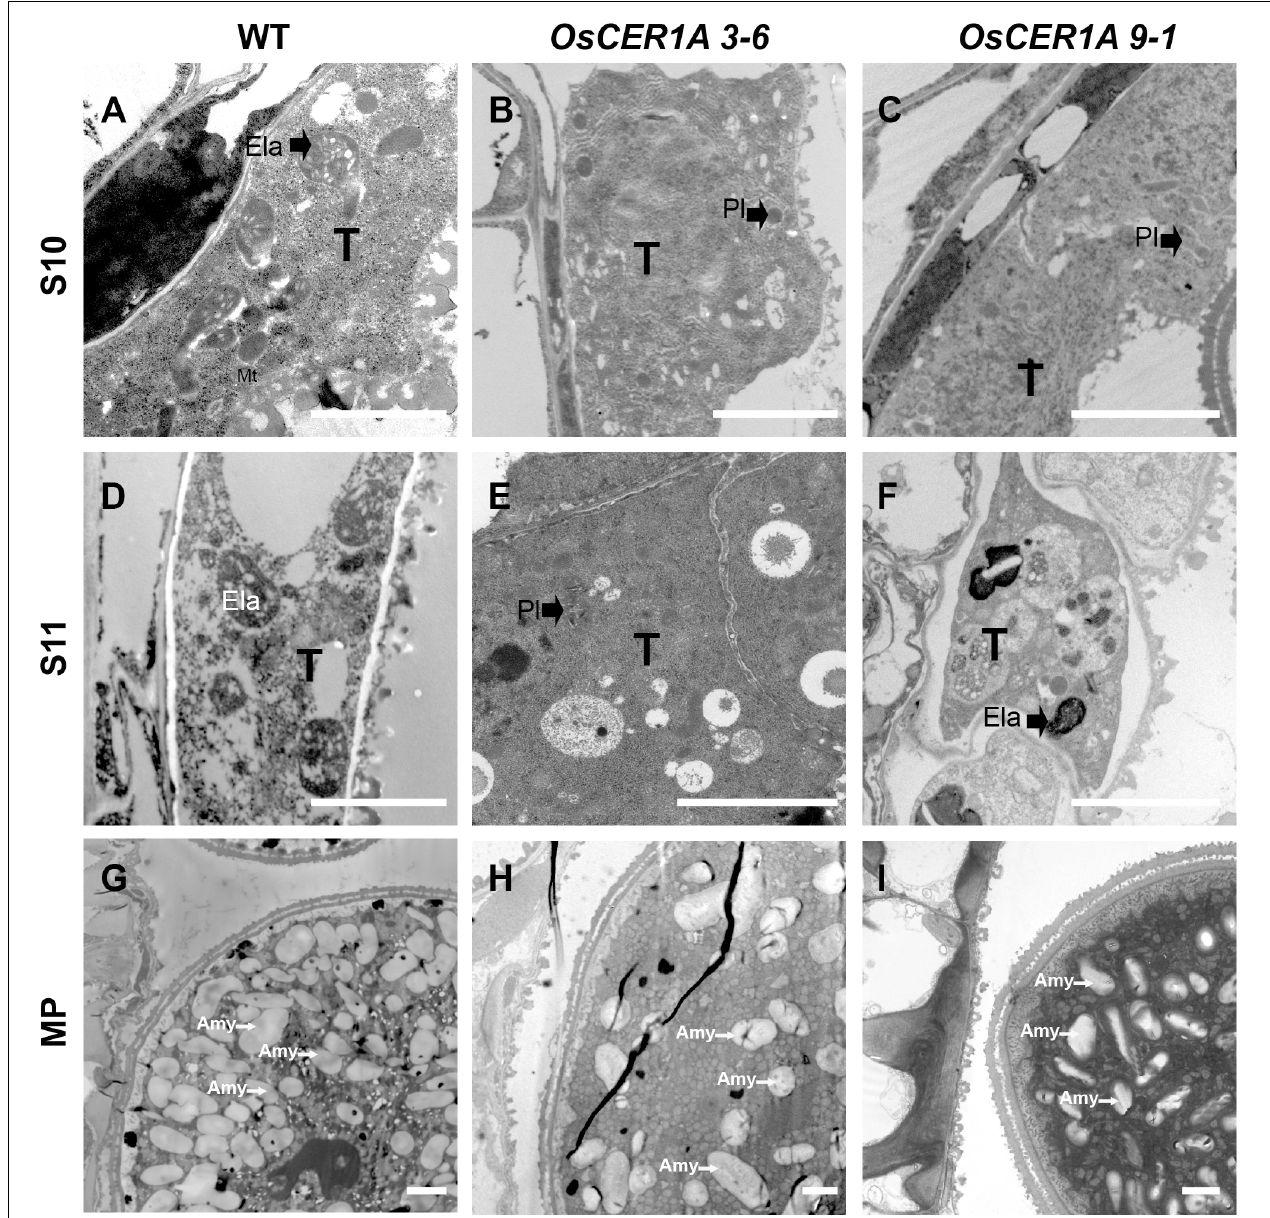
FIGURE 7 | TEM of tapetum cells at stage 10 (S10), at stage 11 (S11) and mature pollen (MP) in the WT plants and OsCER1A lines. (A–C) Tapetal regions at S10 of the WT (A) , OsCER1A 3-6 (B) , and OsCER1A 9-1 (C) plants. (D–F) Tapetum regions at S11 of the WT (D) , OsCER1A 3-6 (E) , and OsCER1A 9-1 (F) plants.